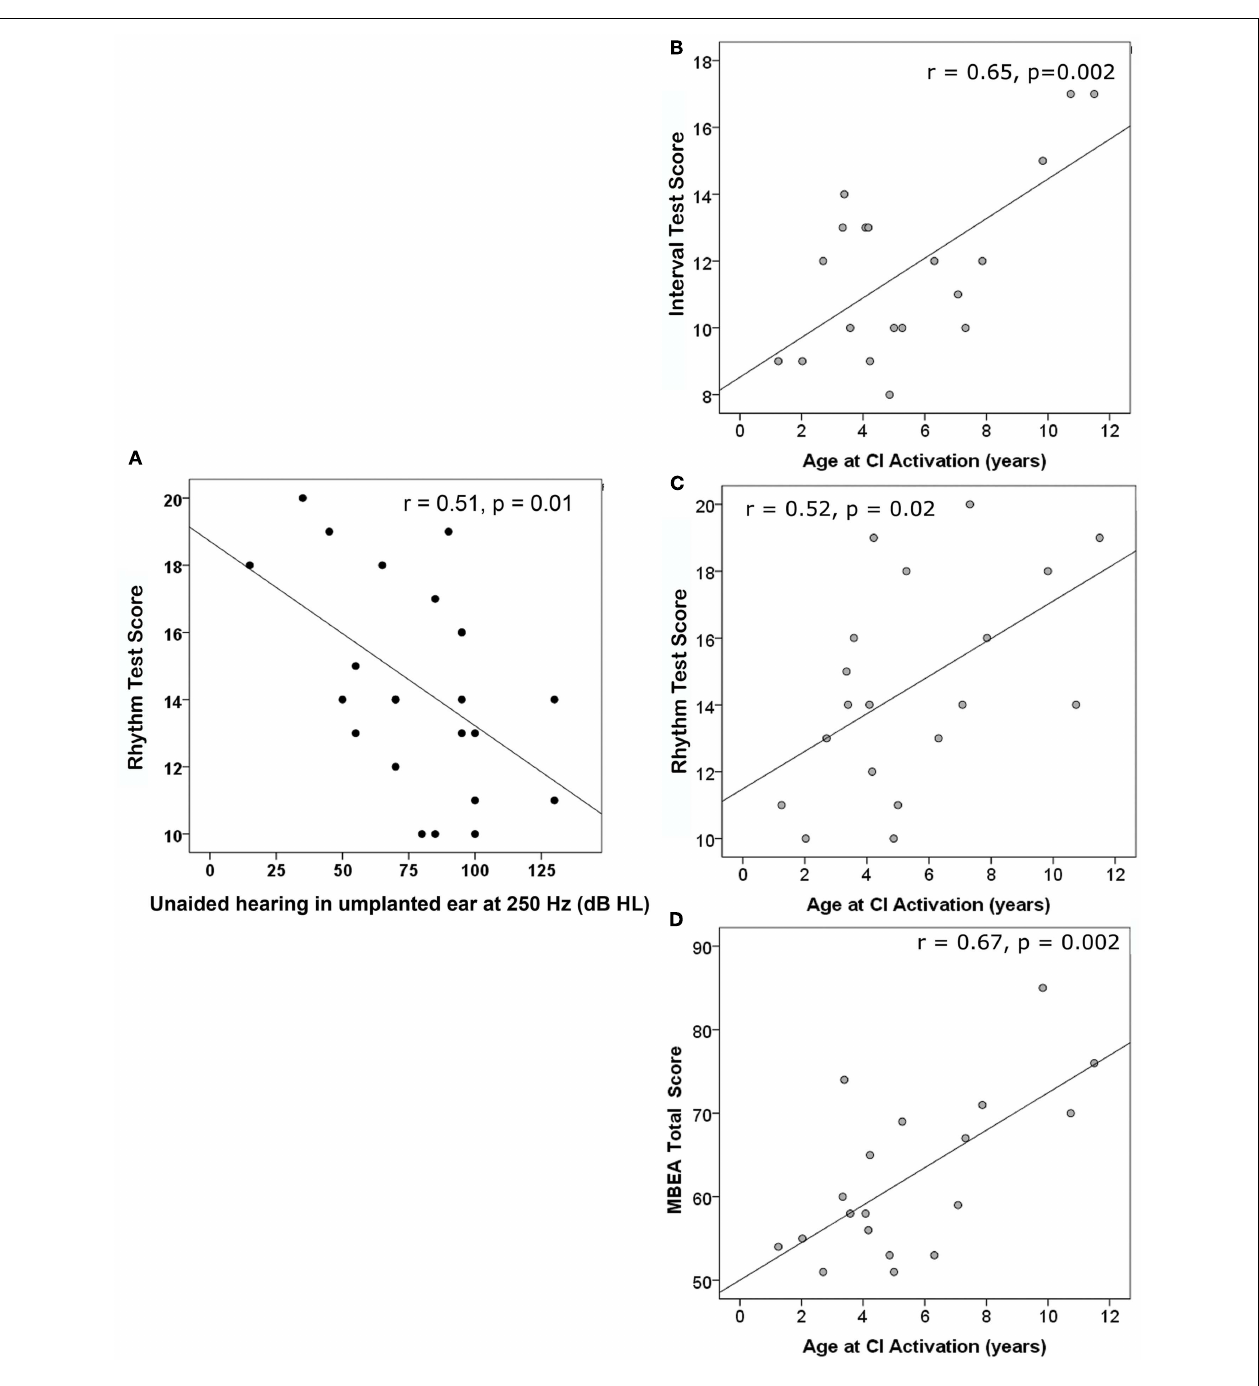
FIGURE 4 | (A) Unaided residual hearing in the un-implanted ear during test was only correlated with one of the MBEA test scores; with better hearing at 250 Hz, Rhythm subtest scores improved.Three scores significantly improved as age at implantation increased: (B) IntervalTest Score, (C) RhythmTest Score, and (D) MBEATotal